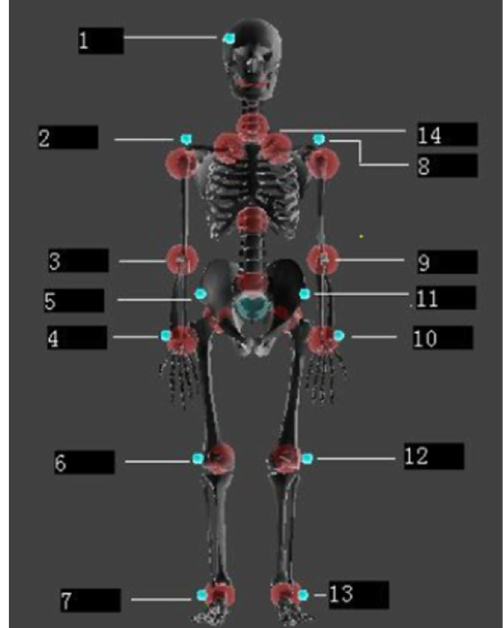
Fig. 3 Human body model and joint